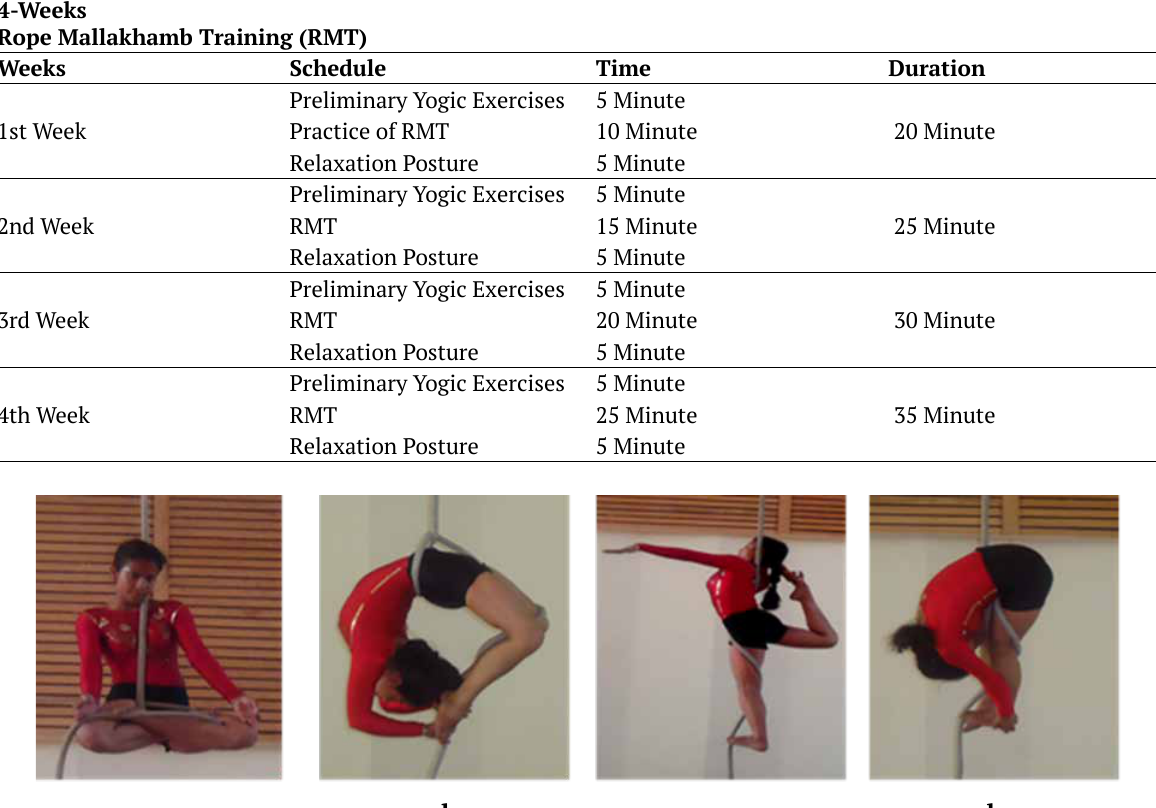
Table 3. Full protocol for 4-weeks Rope Mallakhamb Training.